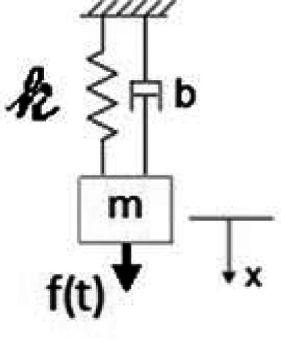
Fig. 1. Mass-spring-damper